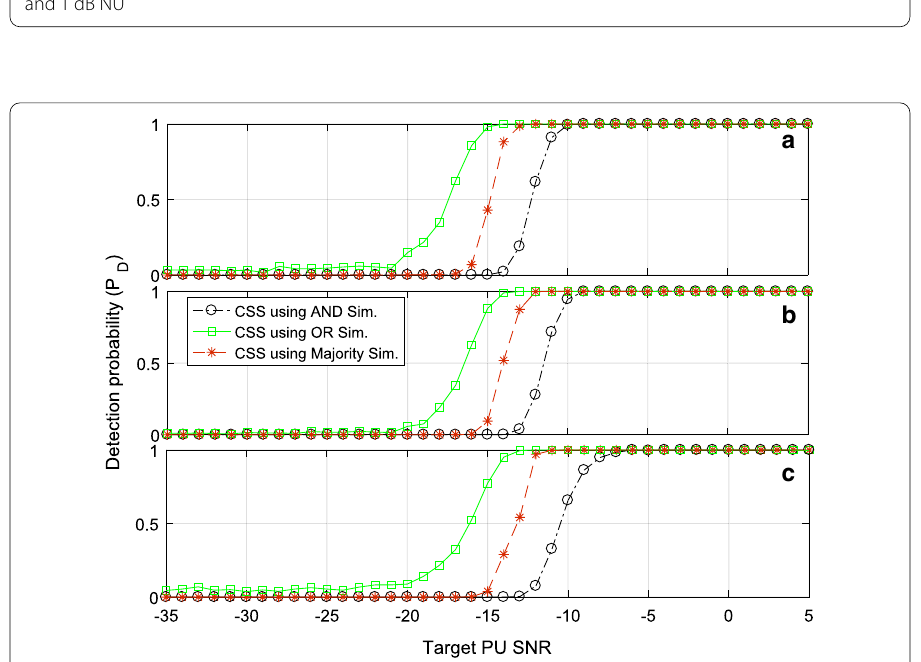
Fig. 9 CSS detection probabilities with a Max–Min ED, b Max/Min ED and c Diff. Max–Min ED and three different linear fusion rules for 2x-oversampled QPSK PU signal under Indoor channel and log-normal fading ( σ = 9dB ), the length of N FFT = 32 , the number of sensing stations M N 20,480, and 1 dB =